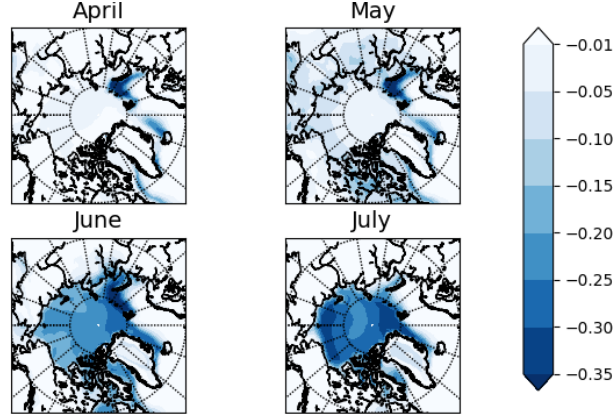
Figure 7. The LIG–PI albedo difference. For both LIG and PI, the albedo for each grid cell was computed from monthly model output variables absorbed and downwelling short-wave flux. The LIG–PI anomaly is computed from the 200-year time averages for the PI and